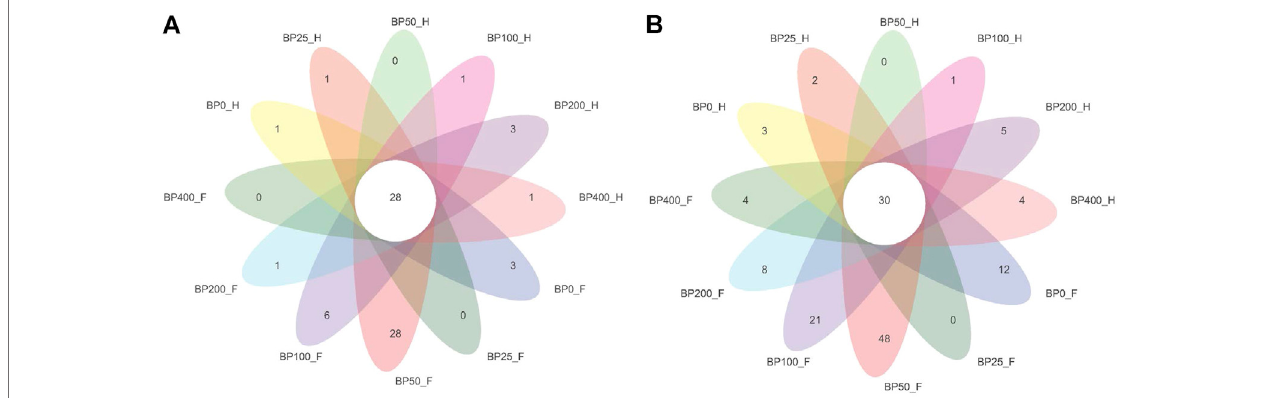
FIGURE 1 | (A) Venn diagram of intestinal microbiota at family level. (B) Venn diagram of intestinal microbiota at genus level.